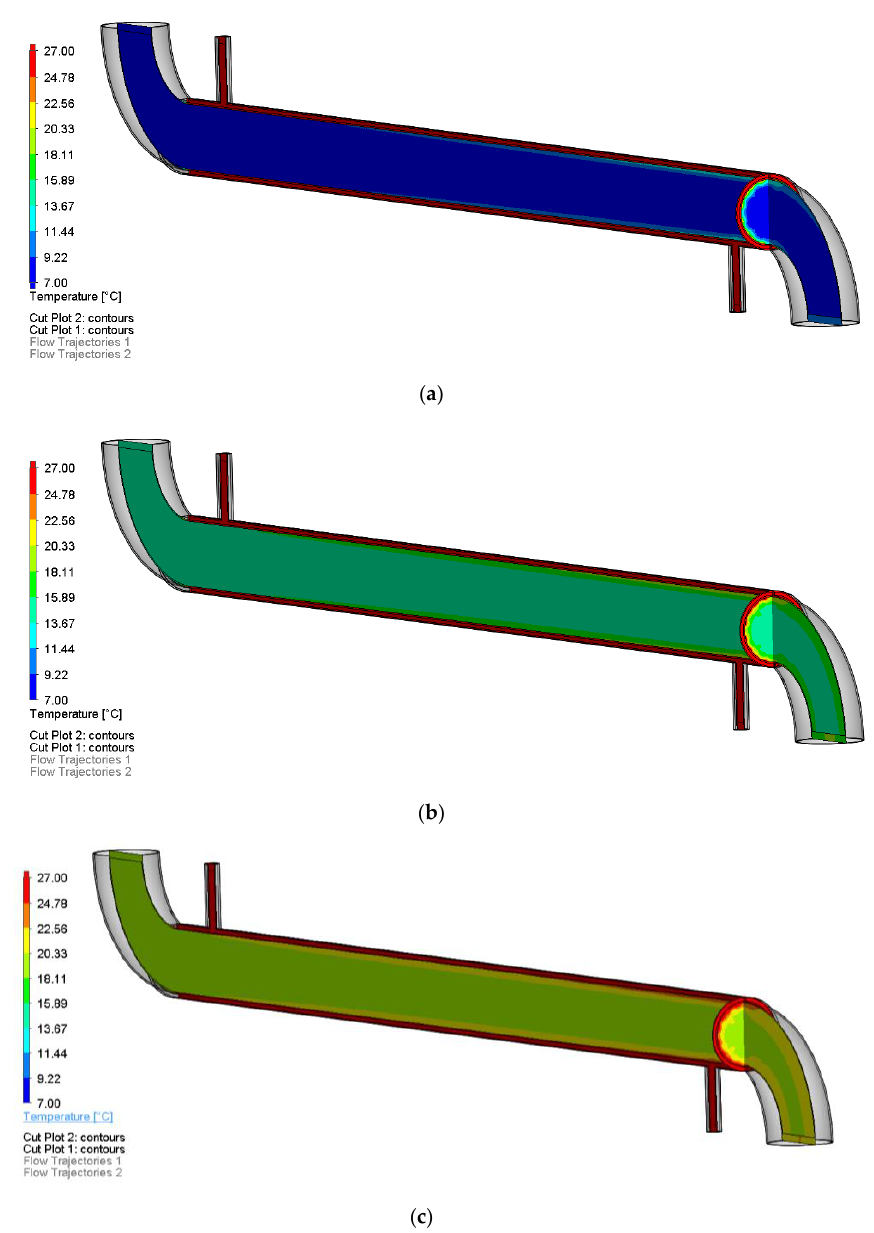
Figure 5. Temperature contours at paste flow rate of 3000 kg/h. ( a ) “Temperature paste in” equal to 7 °C; ( b ) “Temperature paste in” equal to 15 °C; ( c ) “Temperature paste in” equal to 20 °C. As stated, the above is confirmed by the results reported in Figure 5a–c, which shows the temperature contours inside the heat exchanger when the paste flow rate is 3000 kg/h, and the inlet temperature is 7, 15 and 20 °C, respectively. Two cut plots, the first along the longitudinal middle plane and second along the cross section at the end of the straight part of the heat exchanger, describe well the temperature distributions. It should be noted that the core temperature of the product remained virtually unchanged from entry to exit. This means that to obtain the desired temperature throughout the product, a part of it (near the internal surface) will inevitably undergo a qualitative degradation, compromis- ing the quality of the olive oil extracted. In fact, it is easy to note that a large amount of the product (about 80%) still remained at the inlet temperature. The temperature increases from the middle towards the periphery of the section. When the inlet temperature is 15 °C, the product near the wall experiences a maxi- mum temperature of about 20.6 °C (Figure 5b), which becomes about 24.5 °C when it en- ters at 20 °C (Figure 6c). This is due to the rheology of the paste, which always produces a laminar flow and limits mixing, resulting in the absence of uniformity of heating for all portions of olive paste. The laminar flow of the olive paste is also demonstrated by Figure 6a,b, which shows the path lines and velocity values of both olive paste and water. Figure 6a shows very low variation of velocity in the straight part of the inner tube, with a slight variation in the elbows due to gravity. The average velocity of the paste in the inner tube is about 0.14 m/s, while the water flows (Figure 6b) at about 9 m/s in the supply tube, and ones in the jacket undergo a sudden reduction (reaching about 1.5 m/s in the middle of the straight part) and then rise again in the outlet tube. Figure 7a shows the shear rate, which decrease moving through the center of the tube, since the velocity variation between the fluid layers at the center is lower than that near the wall. As a consequence, the dynamic viscosity distribution increases at the center due to the pseudoplastic behavior (viscosity increases when the shear rate decreases), as shown in Figure 7b.